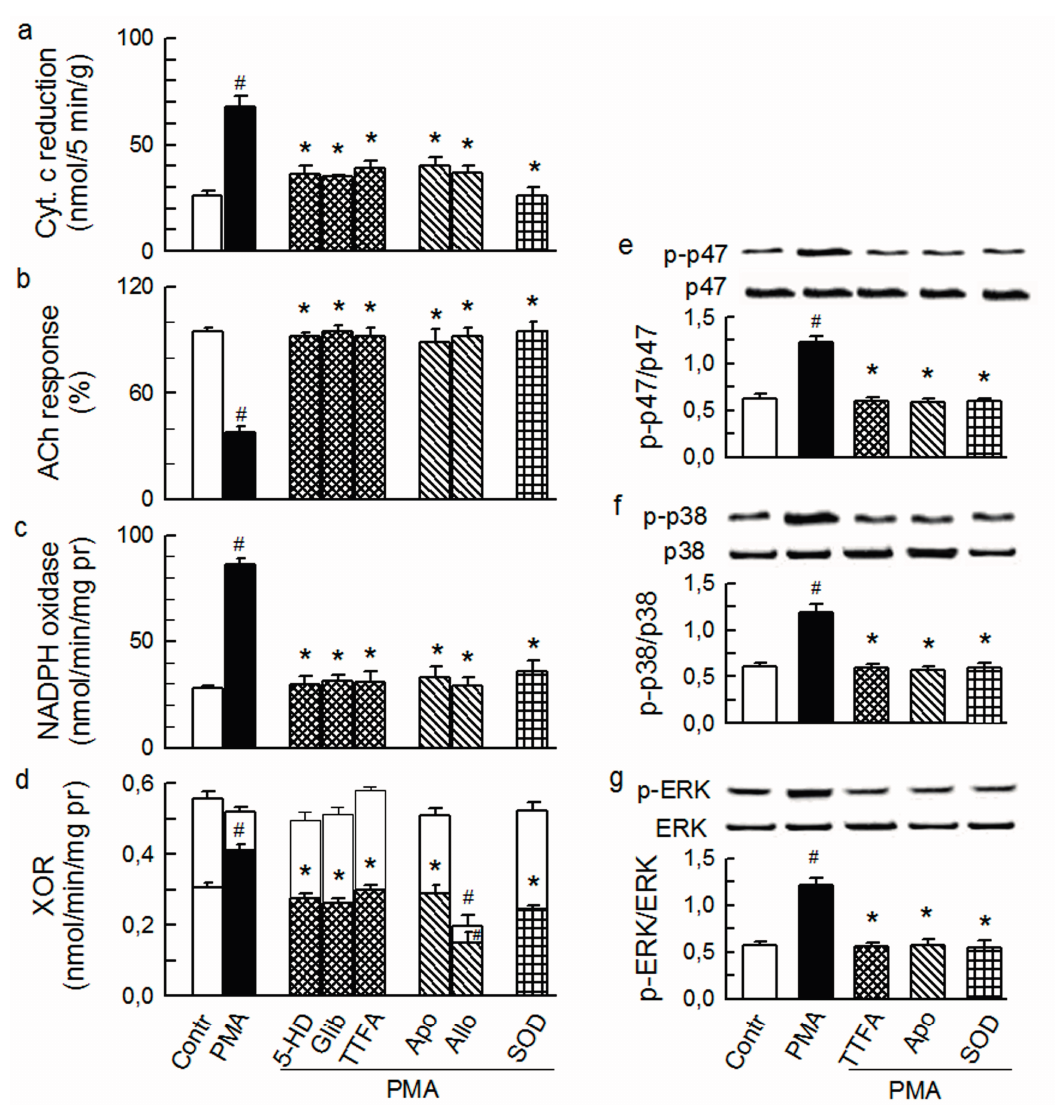
Figure 6. Effect of phorbol 12-myristate 13 acetate (PMA, 1 nM) on the total outflow of reduced cytochrome c ( a ); normalised acetylcholine (ACh) response ( b ); NADPH oxidase activity ( c ); xanthine oxidoreductase activity (XOR) ( d ); phosphorylation of Ser345-p47phox ( e ), p38 ( f ) and ERK1/2 ( g ) in guinea-pig hearts. PMA was given either alone or in combination with (from left to right): 4 μ M chelerythrine (Chele), 100 μ M 5HD, 3 μ M glibenclamide (Glib), 5 μ M TTFA, 1 mM apocynin (Apo), 250 μ M allopurinol (Allo), and 150 IU/mL SOD. Values are means ± SEM of at least five experiments in a –